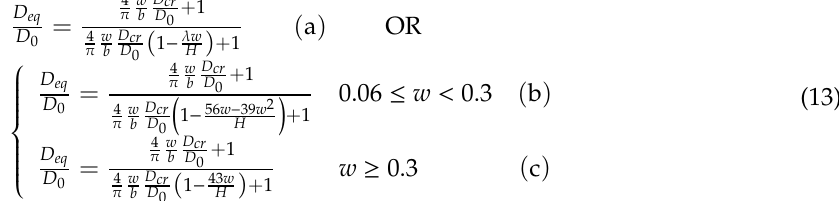
Table 3. Measured diffusion coefficients for various test variables.